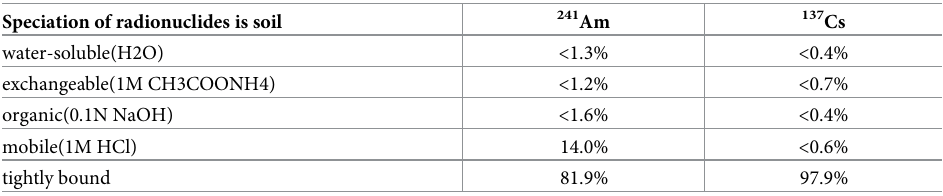
Table 1. Form of radionuclides 137 Cs and 241 Am in the study soil [15]. Speciation of radionuclides is soil 241 Am 137 Cs water-soluble(H2O) <1.3% <0.4% exchangeable(1M CH3COONH4) <1.2% <0.7% organic(0.1N NaOH) <1.6% <0.4% mobile(1M HCl) 14.0% <0.6% tightly bound 81.9% 97.9% Study of radionuclide speciation in soils was conducted by sequential extraction as modified by Pavlotskaya [16].